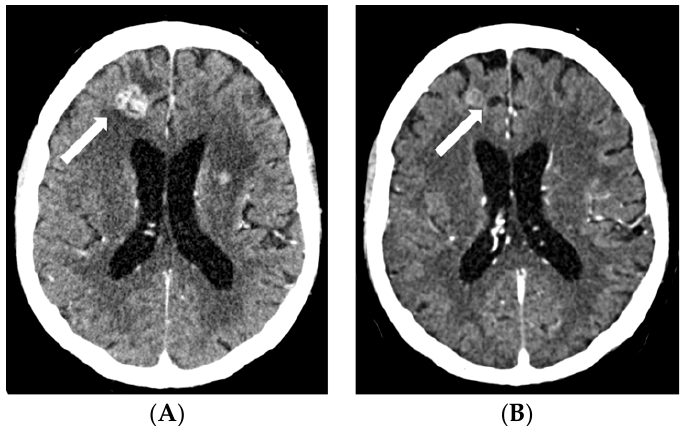
Figure 5. CT scan showing right frontal metastases before (( A ), 19 mm) and after 3 cycles of EV (( B ), 12 mm). Abbreviations: CT, computed tomography; EV, enfortumab vedotin.